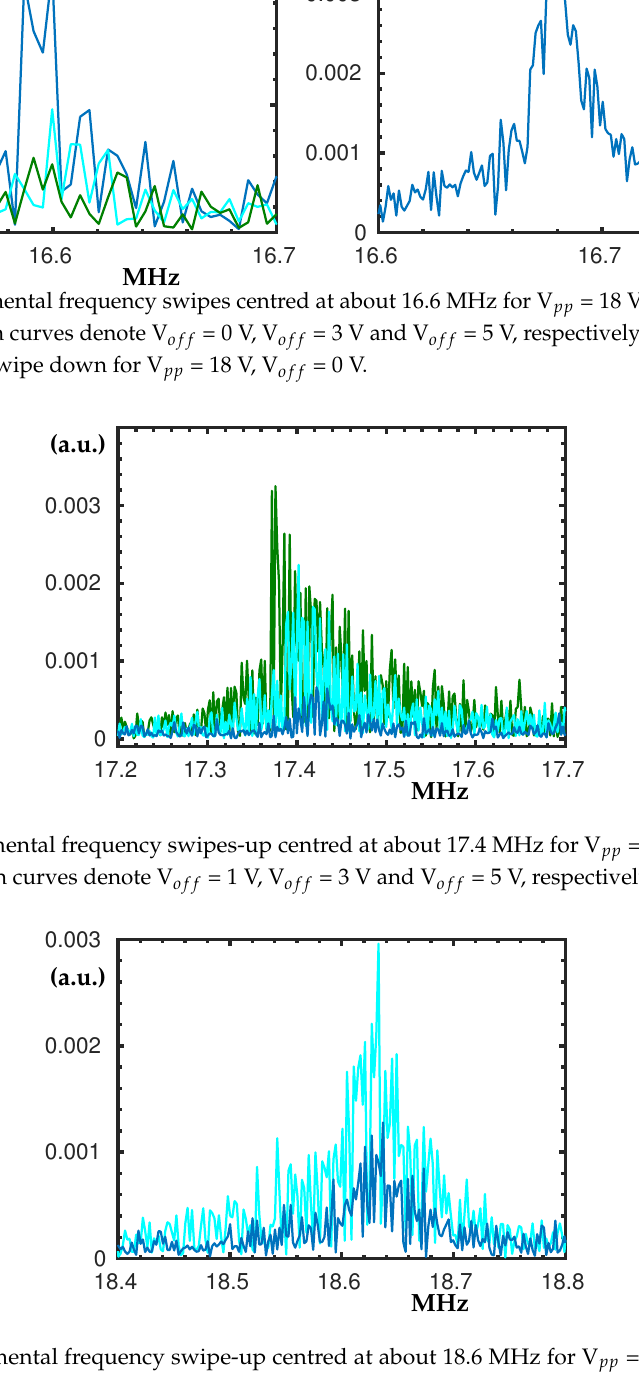
Figure A3. Experimental frequency swipe-up centred at about 18.6 MHz for V pp = 18 V, where the blue and cyan curves denote V of f = 1 V and V of f = 3 V,